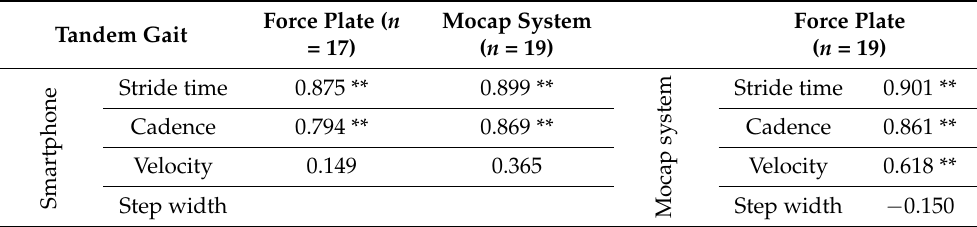
Table 7. Between-system correlations for tandem gait between the force plate, mocap system and smartphone at T1 (first measurement time). Correlation after Pearson.